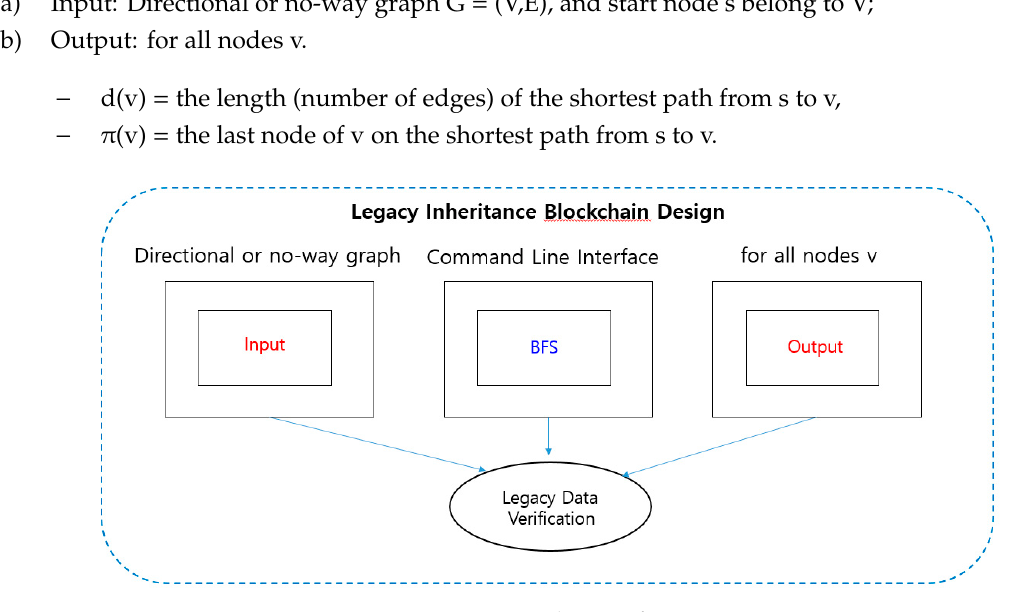
Figure 6. Legacy data verification.